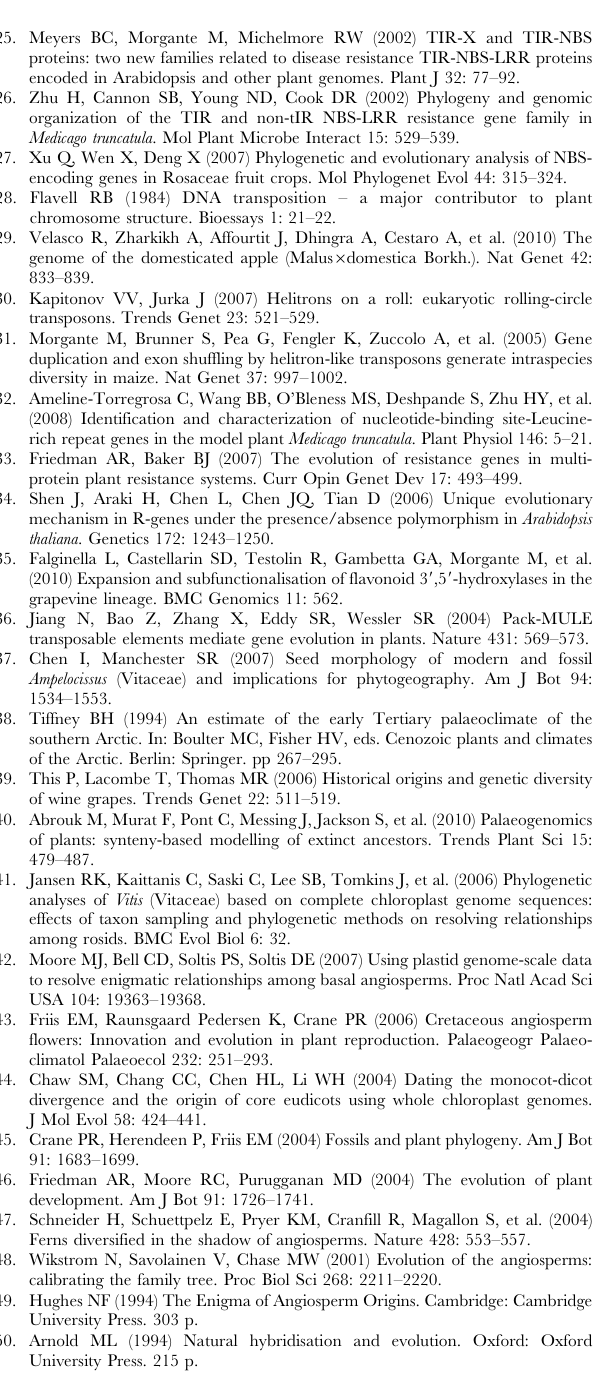
Table S8 Presence in 55 single (R) and six clustered (CL) NBS - R genes of features of helitron transpositive activity, which include the CTAG tetranucleotide and the inverted repeat forming the stem and loop structure. The table includes some of the putative ancestor genes from which single genes may have